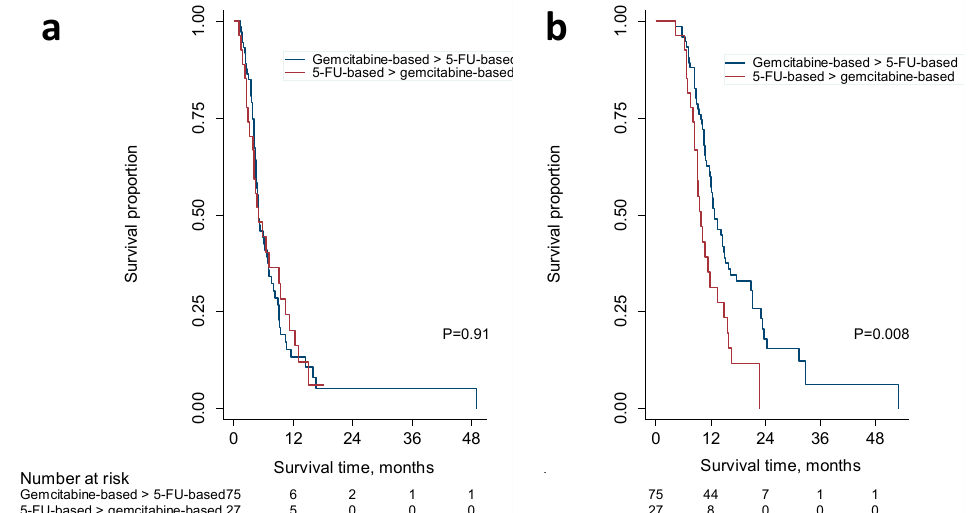
Figure 4. Kaplan–Meier analysis of overall survival associated with second-line systemic chemotherapy ( a ) and the sequence of first- and second-line chemotherapy ( b ). OS was calculated from the discontinuation of first-line treatment ( a ) or the first visit related to a diagnosis of pancreatic cancer ( b ) until the date of death. Patients were stratified into gemcitabine, gemcitabine / capecitabine, or gemcitabine / nab-paclitaxel followed by 5-FU / oxaliplatin, 5-FU / irinotecan, 5-FU, or capecitabine (blue lines) and 5-FU / oxaliplatin / irinotecan or 5-FU / oxaliplatin followed by gemcitabine or gemcitabine / nab-paclitaxel (red lines). Patients were censored if still alive or under treatment at the date their record was accessed or at last follow-up if no information on the current status was available. Log-rank test; p < 0.05 indicates significance.